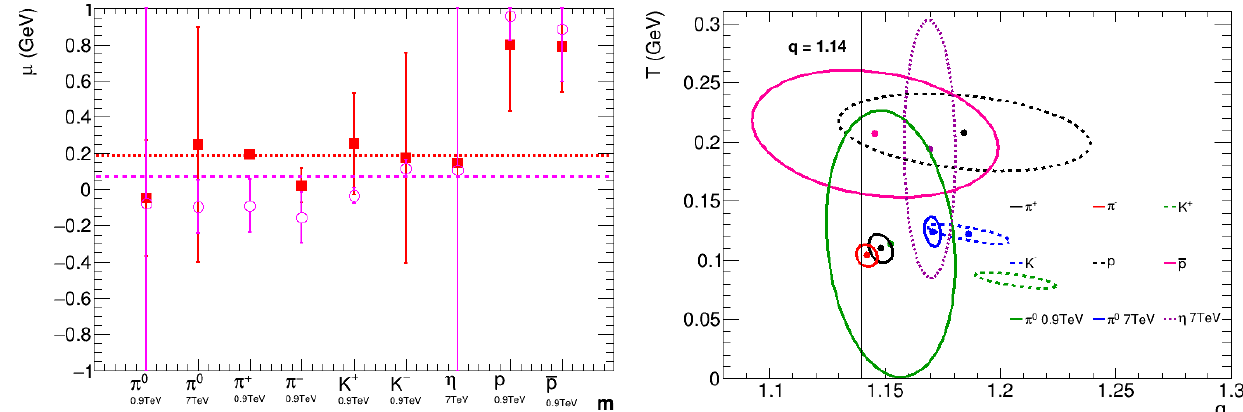
Figure 5. Left : the dependence of the chemical potential, µ , on the particle species. The results are for the Cleymans Formula (1) (solid squares) and for the Lorentz invariant cross-section Formula (8) (open circles). The dotted and dashed lines represent the average value for the chemical potential, obtained by the Cleymans formula and the Lorentz invariant cross-section formula, respectively. Right : the covariances in the T – q plane in the parameter space, corresponding to Lorentz invariant √ s = 7 TeV are indicated by the asterisks and the results for cross-section Formula. The results for √ s = 0.9 TeV are indicated by the solid circles for the centers of the